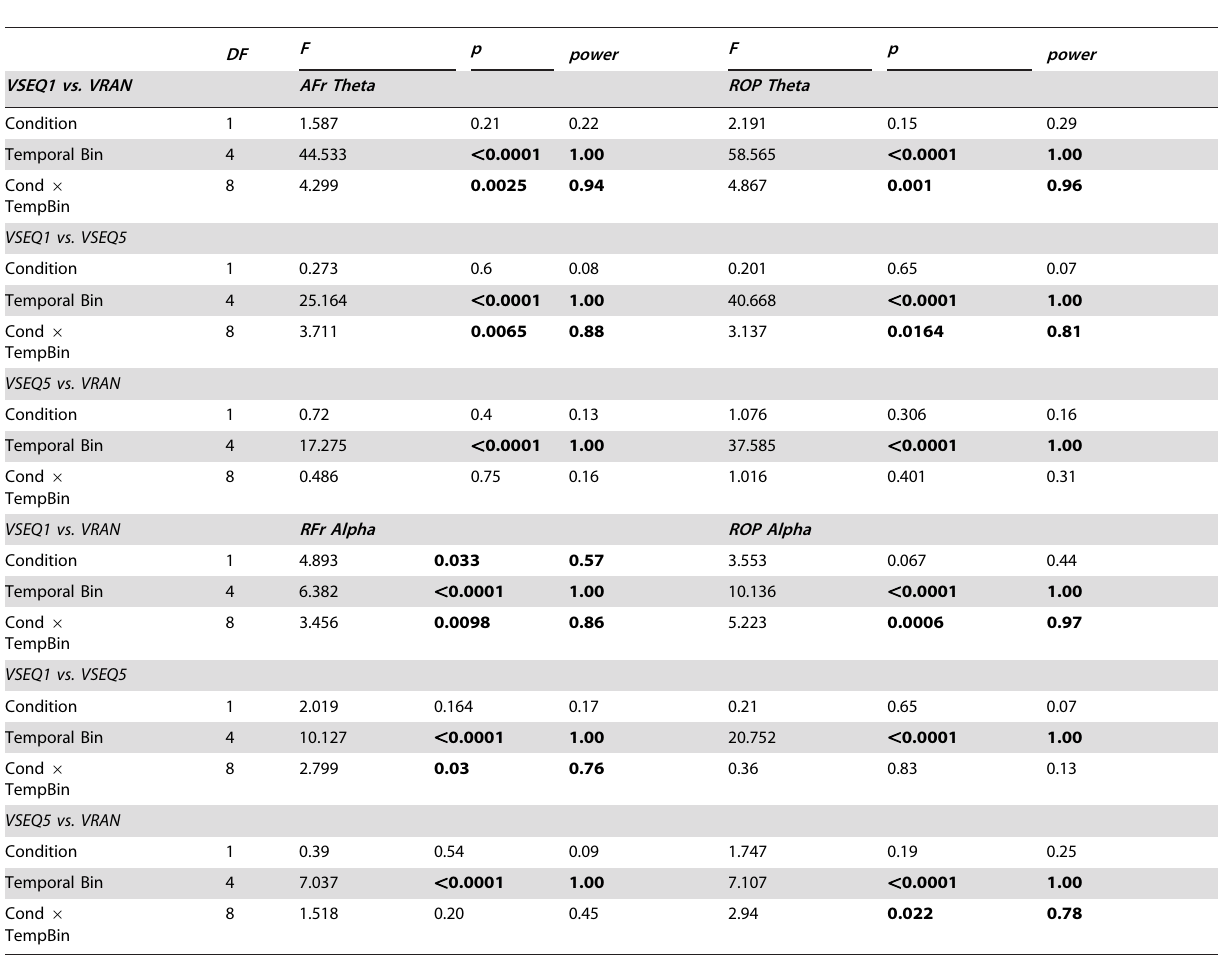
Table 3. Repeated measures ANOVAs in ROP (right occipito-parietal), AFr (Anterior Frontal) and RF (Right Frontal) areas for Theta and Alpha